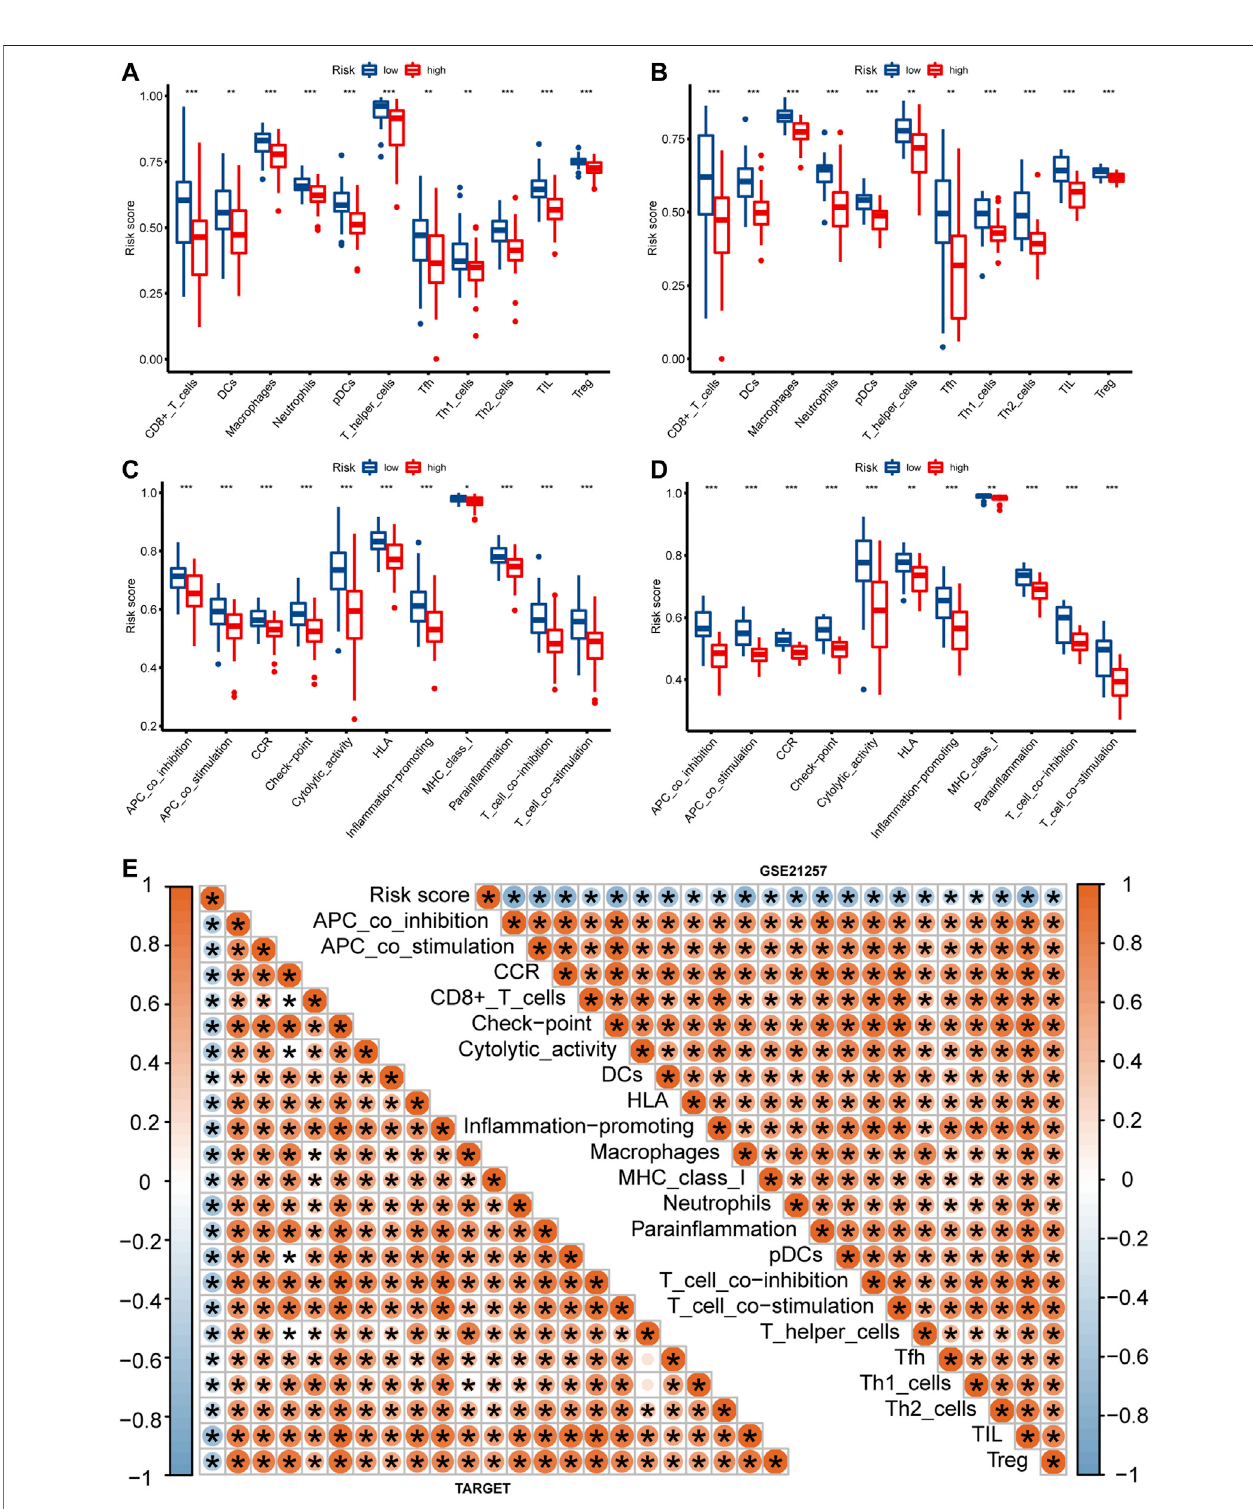
FIGURE7| TherelationshipbetweenIRPSandimmunecellin fi ltrationandimmunefunction. (A,B) BoxplotsofIRPSandimmunecellin fi ltration intheTARGET (A) and GSE21257 (B) cohorts. (C,D) Box plots of IRPS and immune function are in the TARGET (C) and GSE21257 (D) cohorts. (E) Heat map of the correlation between IRPS and immune cells and immune